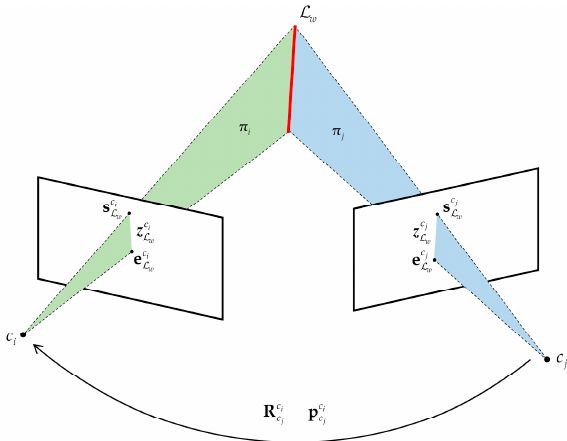
Figure 2. Line feature triangulation.